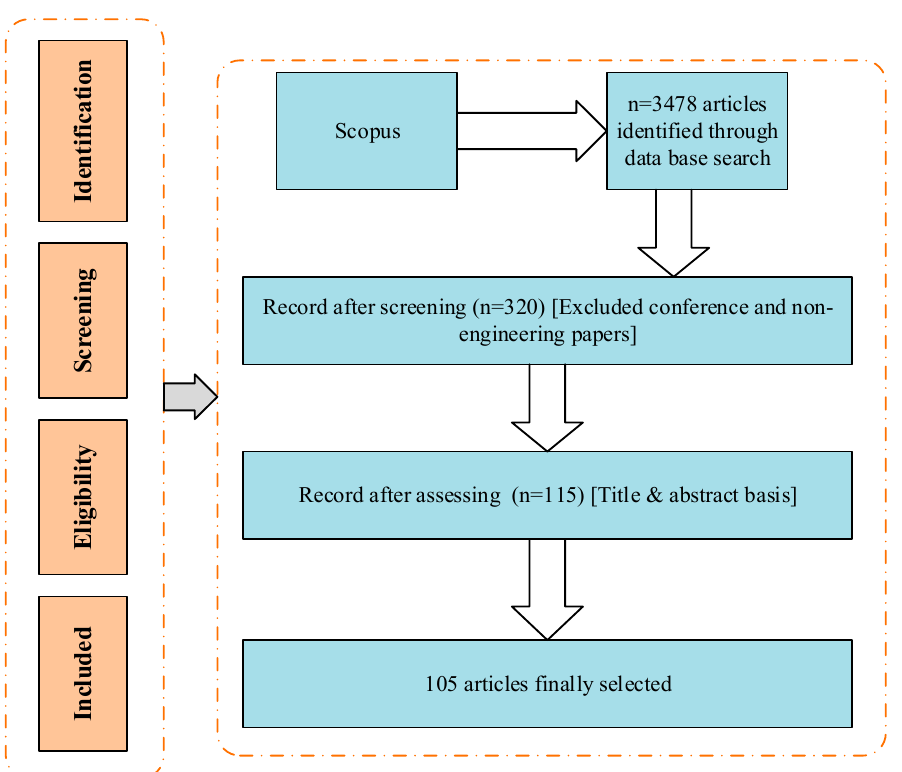
Figure 1. Research flowchart design.